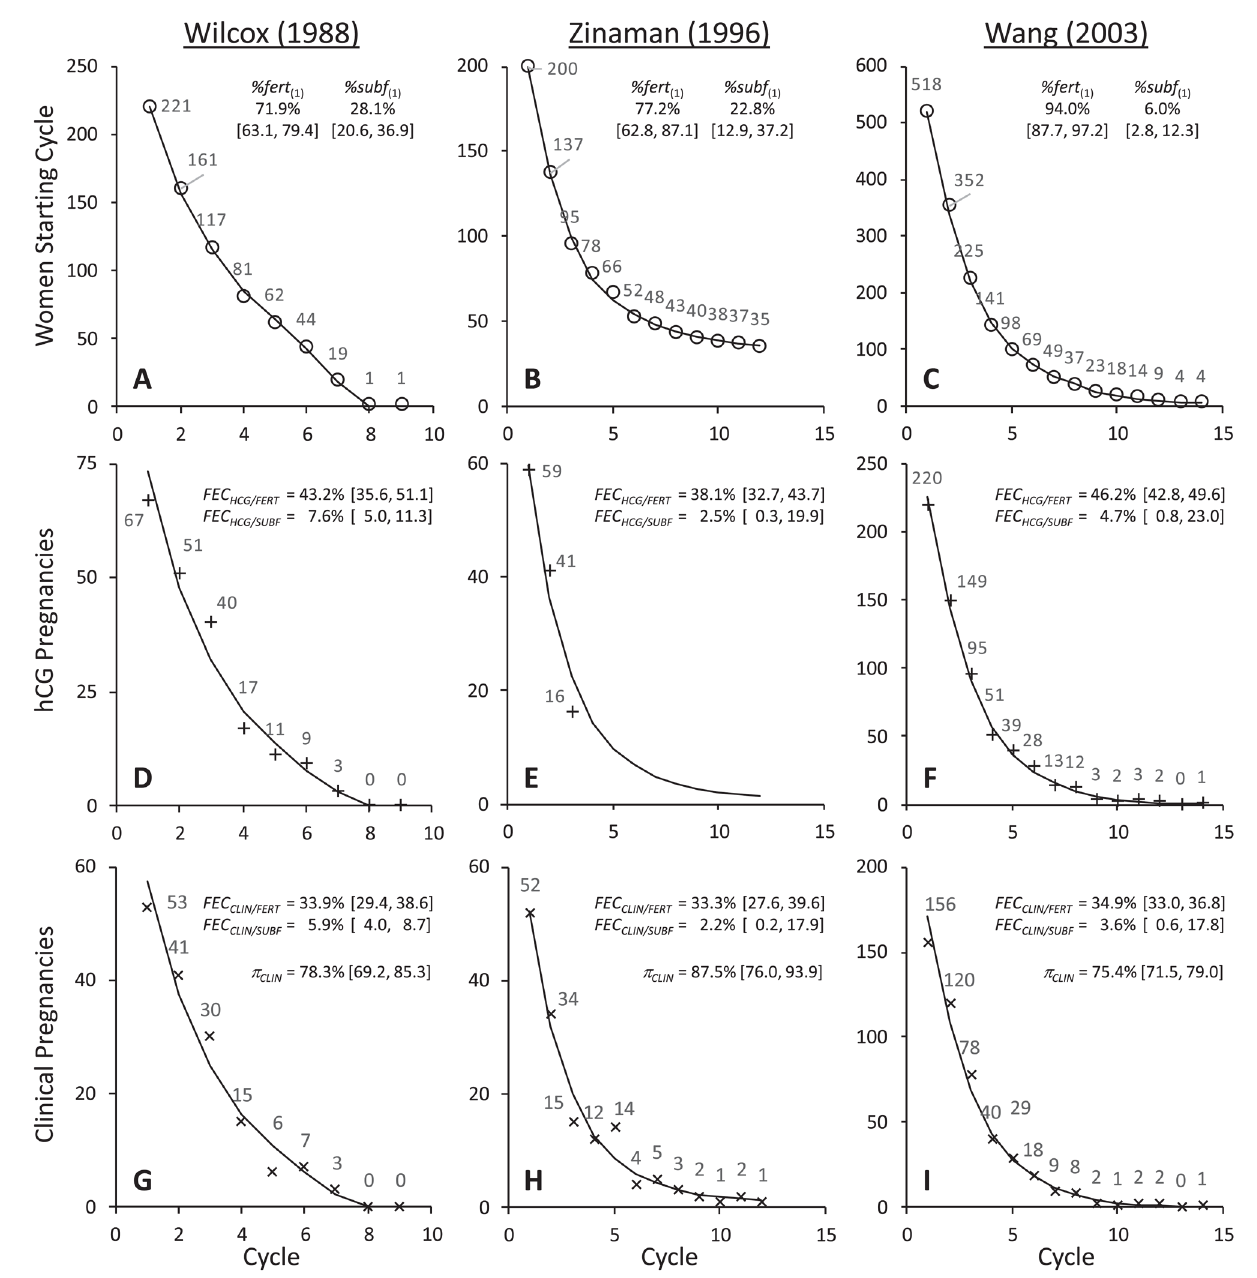
Figure 1. Graphical representation of data and best fit models for Wilcox (A, D, G), Zinaman (B, E, H) and Wang (C, F, I) studies. Each panel shows the data value from the study for each point ( = women starting cycle; + = hCG pregnancies; × = clinical pregnancies). The line  indicates the best fit models as defined in Table 1. Parameter estimates and [95% confidence intervals] from these models are also shown.